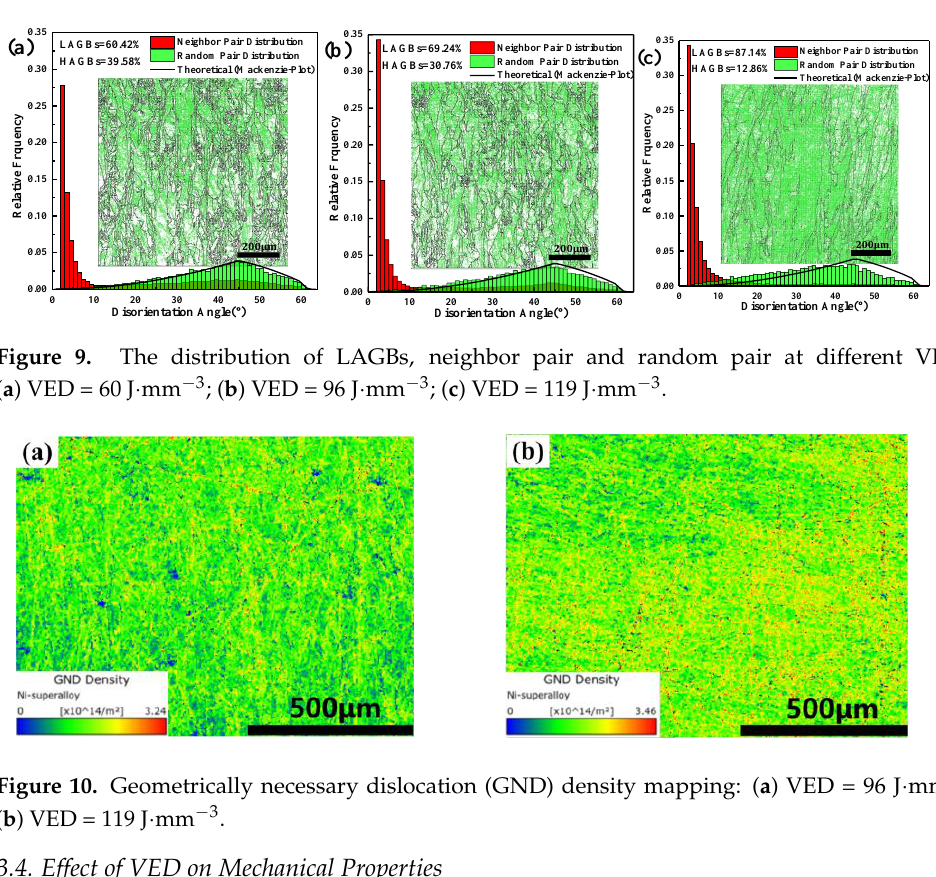
8 of 12 Figure 8. Pole figure (PF) under different VEDs: ( a ) VED = 60 J·mm −3 ; ( b ) VED = 96 J·mm −3 ; ( c ) VED = 119 J·mm −3 . In Figure 9, the distribution of low angle grain boundaries (LAGBs) is shown in mi- crographs with a green color, and the red histogram shows the statistical distribution of misorientation among the grain boundaries. It can be seen from Figure 9, that when the VED increases from 60 J·mm −3 to 119 J·mm −3 , the low angle grain boundaries (LAGBs) are increased from 60.42% to 87.14%. The increase of VED led to the increase of content of LAGBs. Based on the analysis of LAGBs, there were many deformed grains with a high dislocation density inside the material. The cause may have been the accumulation of dis- location density caused by thermal stress. As shown in Figure 10, the geometrically nec- essary dislocation (GND) density increased as the VED increased from 96 J·mm −3 to 119 J·mm −3 . This indicates that the grain strain also increases with the increase of VED. Grain